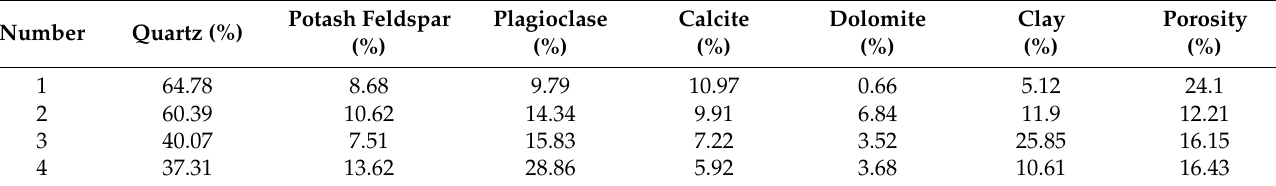
Table 2. Mineral content and porosity of the four samples.